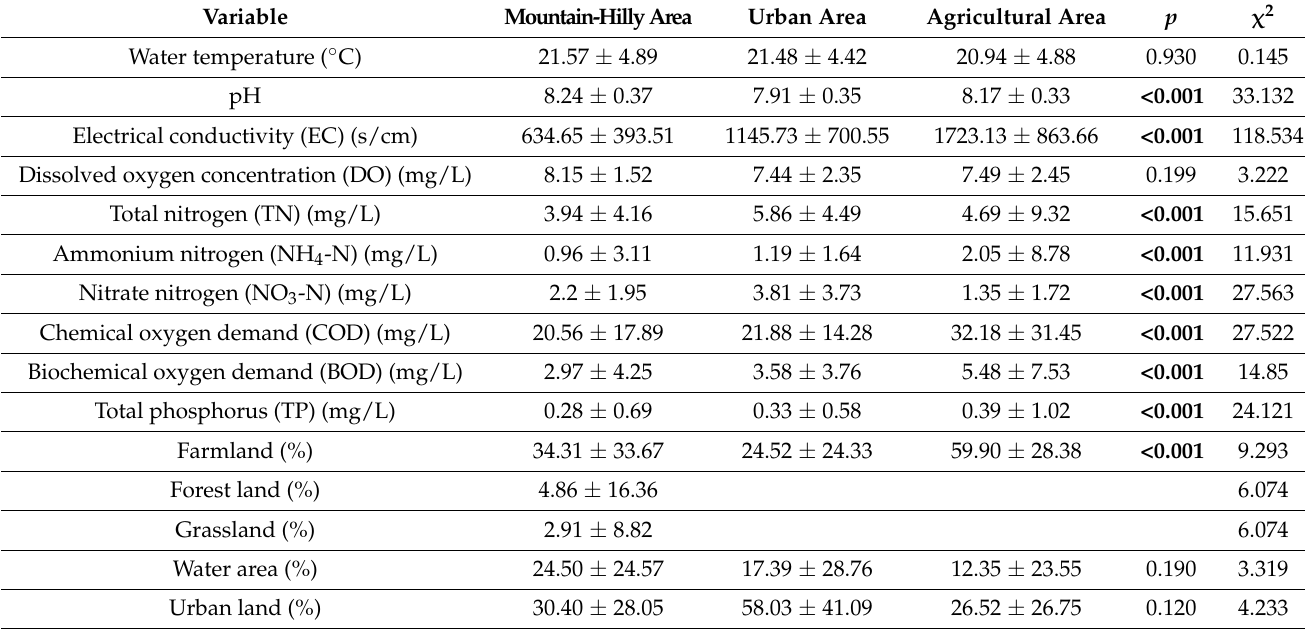
Table 2. Comparison of environmental variables (mean ± SD) in different land use type sites. Significant differences in environmental variables across different types of land use are indicated in bold (Kruskal-Wallis Test: p < 0.05). Mountain–hilly areas (15 sites); urban areas (15 sites); agricultural areas (14